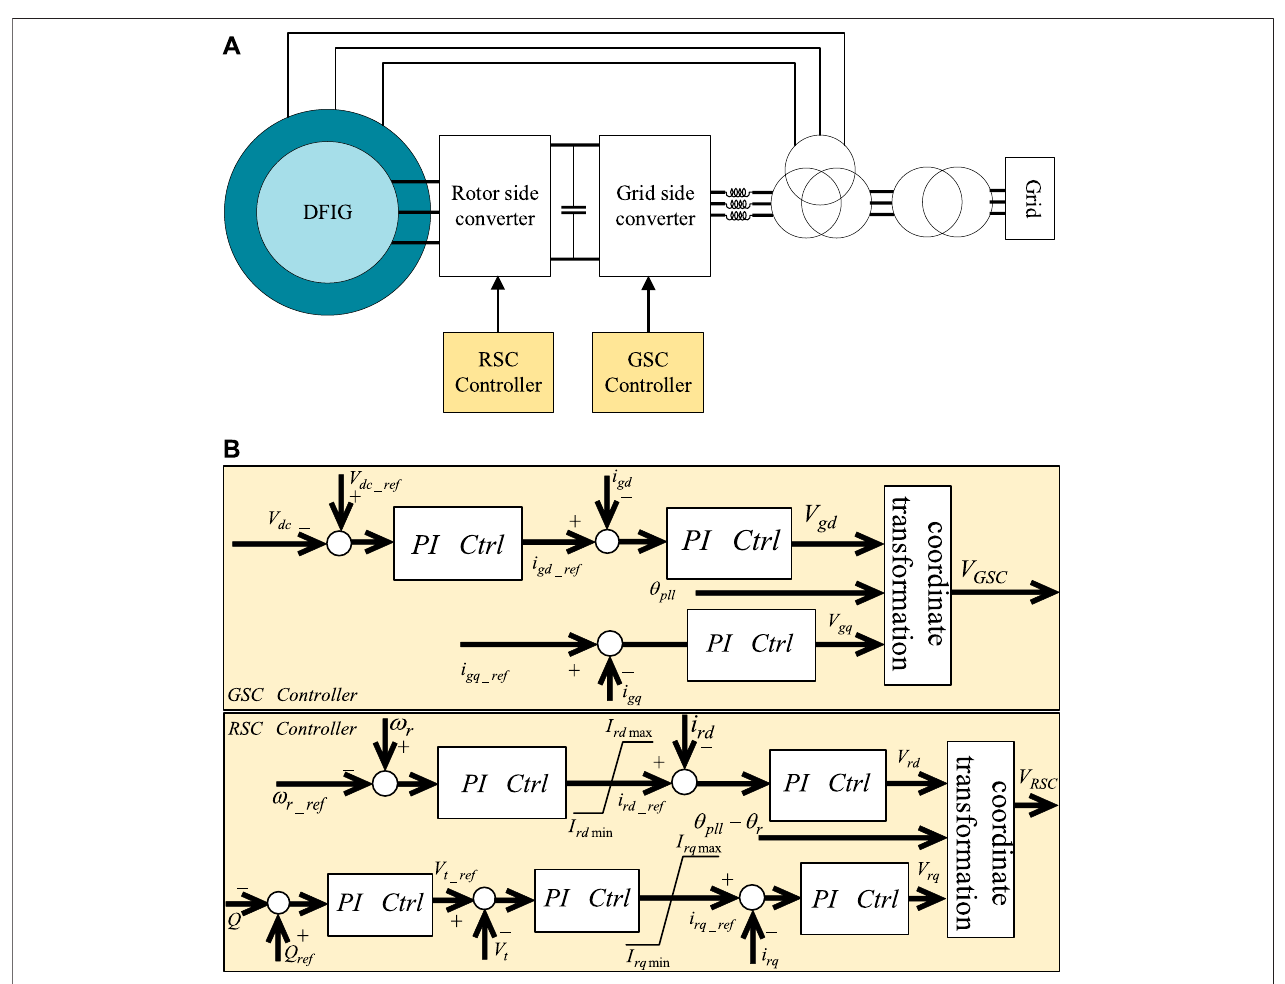
FIGURE 1 | (A) Typical DFIG model. (B) Control module of the typical DFIG model.